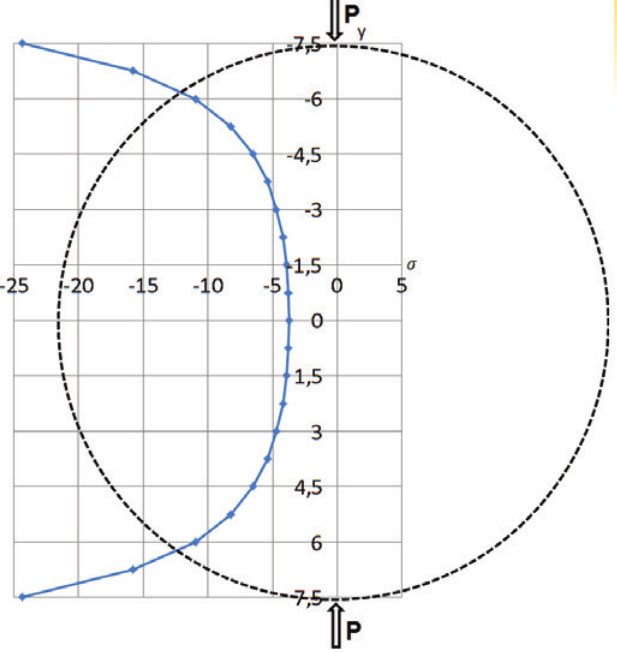
Distribution of normalized stress σ